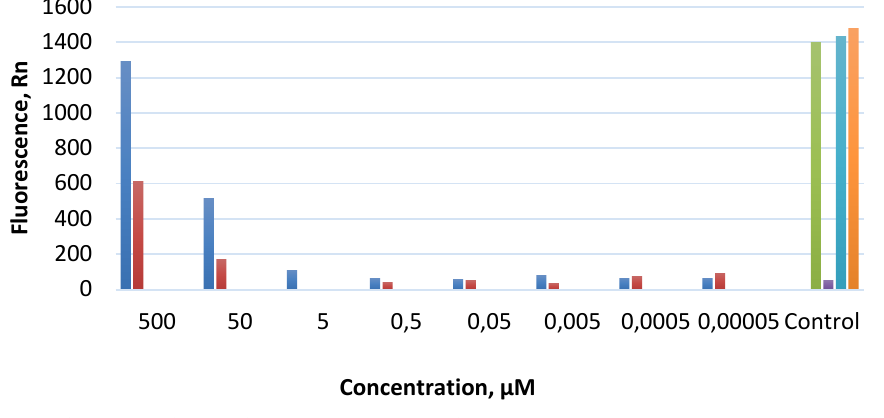
Figure 5. Inhibition of PI3K α enzymatic activity with compounds 7b (blue) or 7c (red). Both tested compounds inhibited PI3K α . Apparently, compound 7b (blue bars) was a more potent inhibitor of PI3K α than its congener 7c (red bars). IC 50 for 7b was about 50 µ M, which is an order of magnitude lower than for 7c . The solutions of single PI3K α (violet bar), of PI3K α mixed with its covalent inhibitor wortmannin (0.1 µ M) (azure bar), and of single wortmannin (orange bar) were used as positive and negative controls. The green bar represents a signal of the reaction mixture with neither enzyme nor inhibitors. As well as the immunoblotting experiment (Figure 4), where the blockade of key downstream phosphorylation effectors of the PI3K cascade has already appeared in the presence of 125–250 nM 7c , the data on inhibition of PI3K may suggest that this enzyme is a minor target of 7c among the proteins of PI3K/Akt/mTOR cascade.